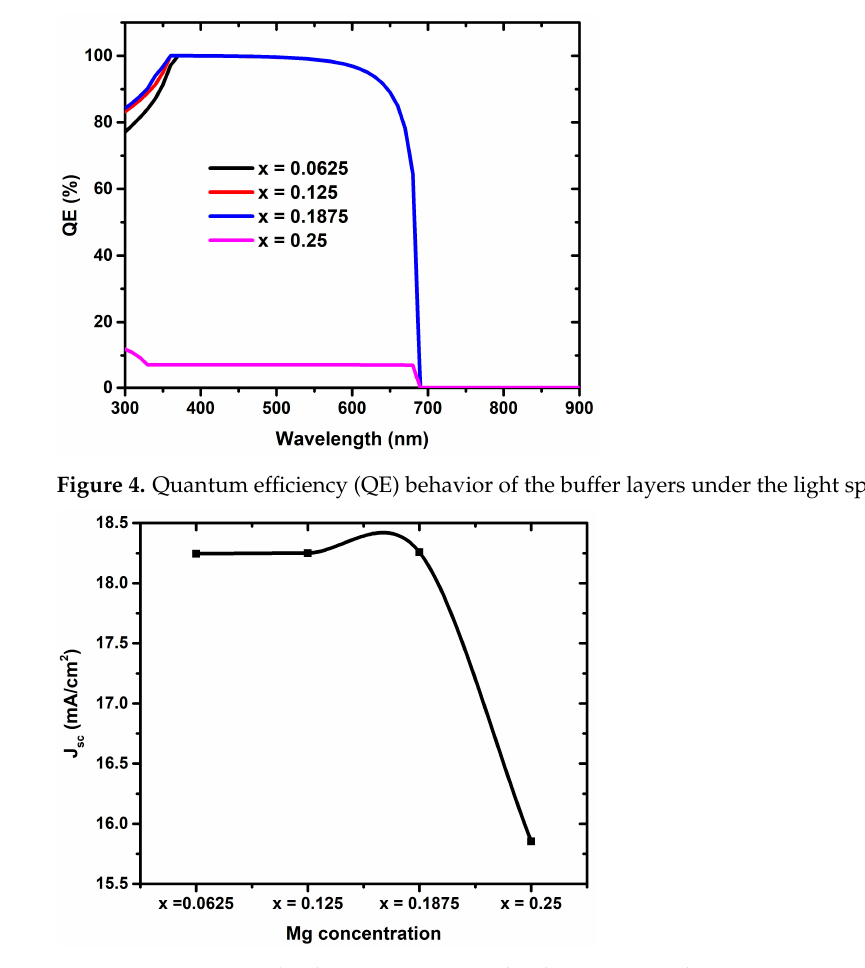
Figure 5 . Variation in the short circuit current (J sc ) by increasing the Mg concentration in Zn 1 − x Mg x O.